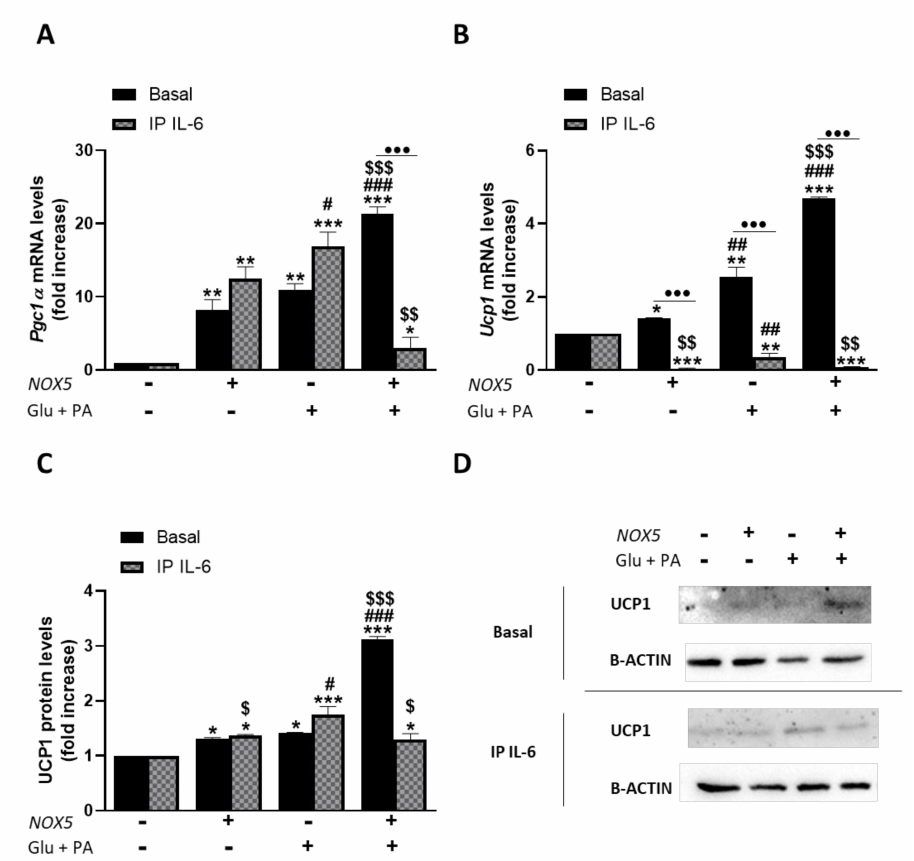
Figure 6. 3T3-L1 adipocytes showed an increased expression of thermogenesis genes when cultured for 24 h with Glu + PA conditioned media from NOX5-expressing endothelial bEnd.3 cells. This increase is prevented when IL-6 is immunoprecipitated from the media (IP IL-6). ( A , B ) Pgc1 α and Ucp1 mRNA levels of 3T3-L1 adipocytes ( n = 6). ( C ) UCP1 protein levels of 3T3-L1 adipocytes ( n = 6). ( D ) Representative images of Western blots for UCP1. mRNA levels are relative to Gapdh ; protein levels are relative to B-ACTIN. Fold increase is relative to control group (Nox5( − )/Glu + PA( − )). Results are expressed as median plus confidence interval; * p < 0.05, ** p < 0.01, *** p < 0.001: differences relative to Nox5( − )/Glu + PA( − ); # p < 0.05, ## p < 0.01, ### p < 0.001: differences relative to Nox5(+)/Glu + PA( − ); $ p < 0.05, $$ p < 0.01, $$$ p < 0.001: differences relative